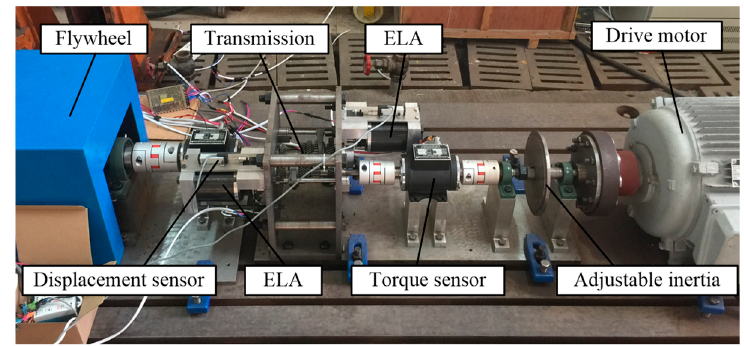
Figure 3. The test bench of motor-AMT coupled drive system.